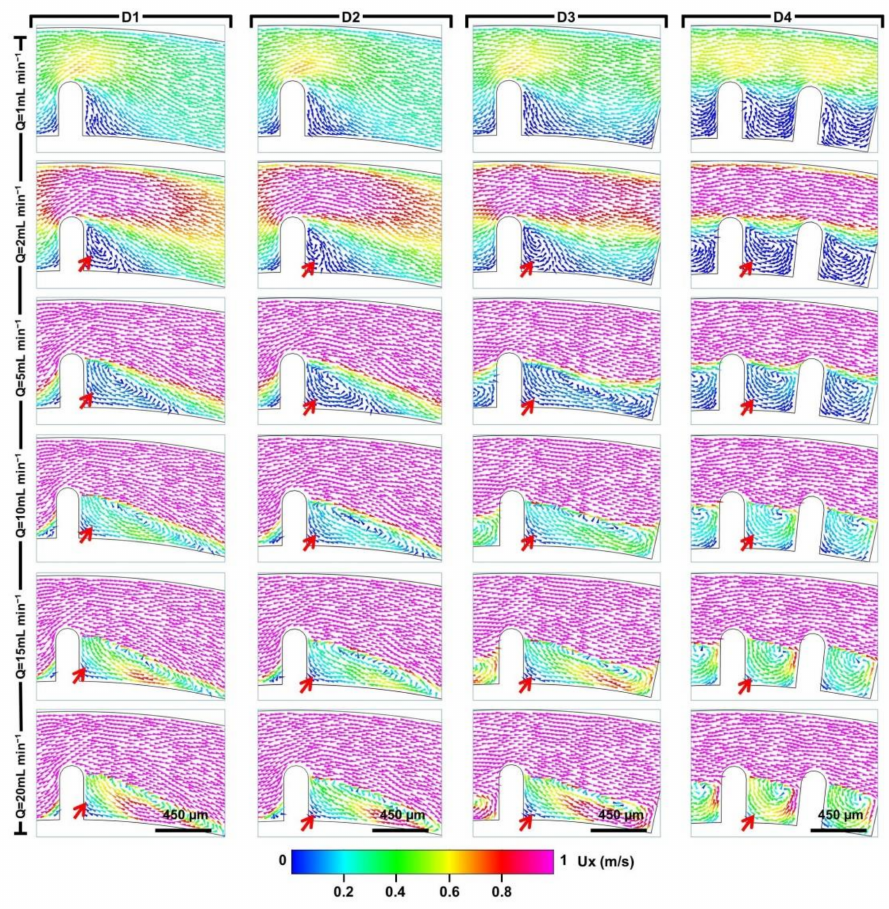
Figure 2. Simulated fluid velocity field of helical vortex induced by micro-bars along the D-channels (D1, D2, D3, D4) under various flow conditions (1 to 20 mL min − 1 ). The red arrows represent different vortex distributions. Ux represents the fluid velocity field in the horizontal plane and refers to the main flow direction from the inlet to the